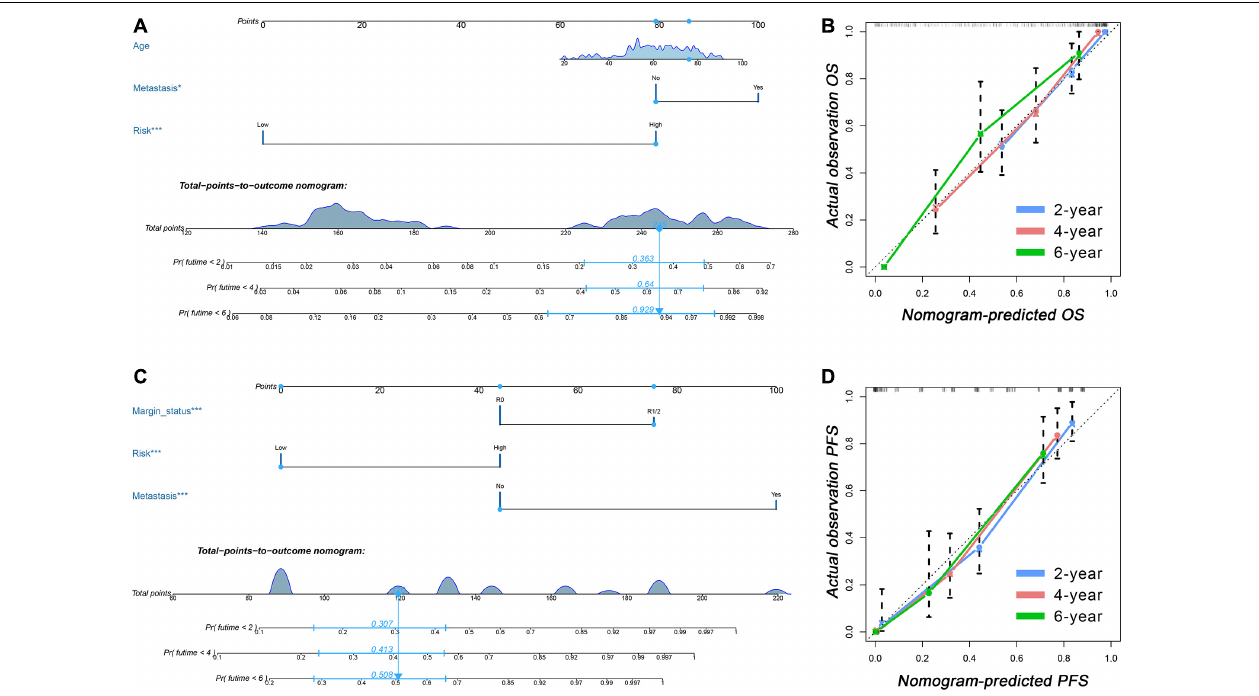
FIGURE 6 | Clinical-APA nomograms for sarcoma. (A) A nomogram incorporated APA signature and prognostic clinical data was established to predict OS of sarcoma patients. (B) Calibration curves showed that nomogram-predicted OS were highly consistent with actual OS. (C) A nomogram incorporated APA signature and prognostic clinical data was established to predict PFS of sarcoma patients. (D) Calibration curves showed that nomogram-predicted PFS were highly consistent with actual PFS. APA, alternative polyadenylation; OS, overall survival; PFS, progress